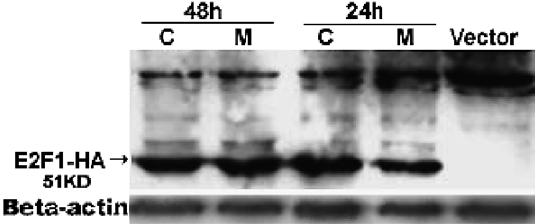
Fig. 4. Western blot analysis of E2F-1 protein levels in hu- man gastric carcinoma cells transfected with pCMV-E2F-1-HA. MKN-45 and COS-7 cells were transiently transfected in vitro with pCMV-E2F-1-HA. Cellular proteins were extracted from the cells at 24 and 48 h after transfection, and the level of E2F-1 protein was analyzed by Western blotting. β -Actin was utilized as a control to verify equal protein loading and transfer. Shown are Western blot data representative of those obtained from three separate experiments. C, COS-7 cells transiently transfected with pCMV-E2F-1-HA; M, MKN-45 cells transiently transfected with